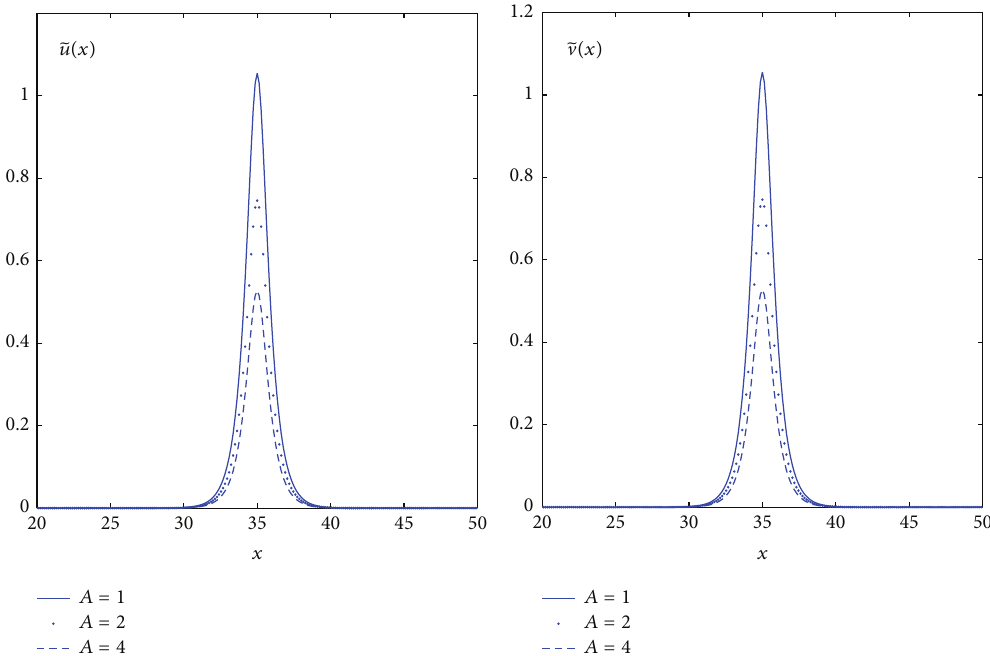
Figure 8: Effect of the model’s coefficients on the shape of the soliton solutions. Here 𝑒 ≡ 0 , 𝛿 = 1 , 𝛼 1 = 𝛼 2 = 1.5 , 𝜎 1 = 𝜎 2 = 0 , 𝐾 = 0.5 , = 35 , and 𝑎(𝑥) = 𝑏(𝑥) = 𝑐(𝑥) = 𝑑(𝑥) = 𝐴 sech (𝑥 − 𝑥 𝑥 0